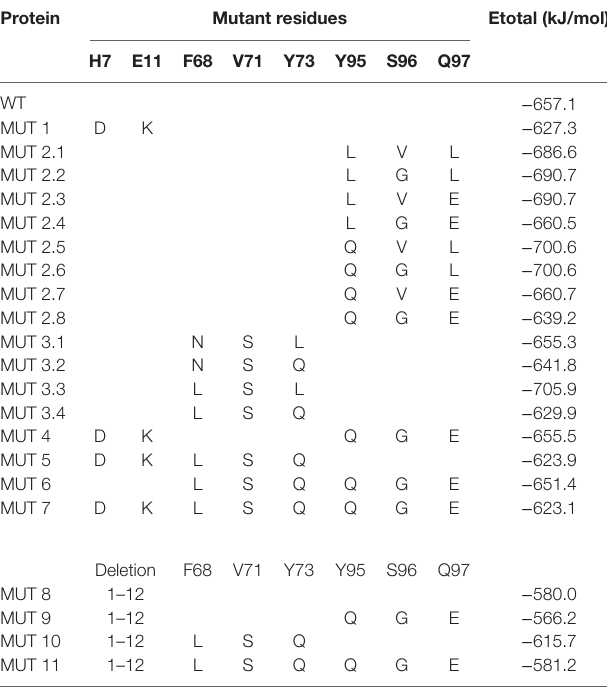
TaBle 3 | Protein–protein docking energies of CRF-BP to CRF 2 α R mutants. Protein Mutant residues etotal (kJ/mol)